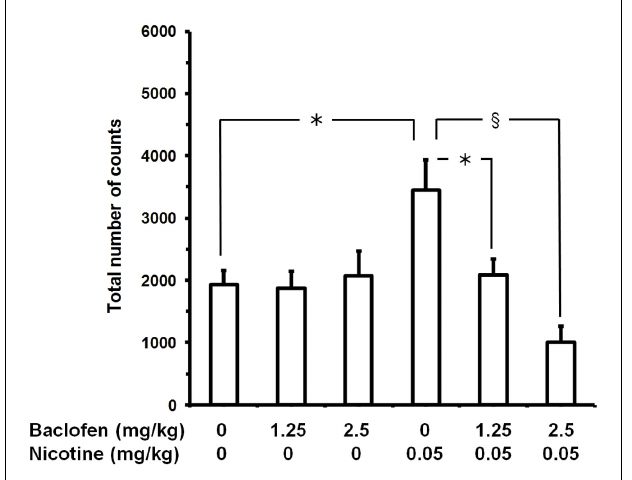
FIGURE 1 | Prevention of nicotine-induced hyperlocomotion by baclofen in male CD1 mice. Mice were initially treated with baclofen (i.p.); 60min later, mice were treated with nicotine (tartrate salt). Locomotor activity recording started immediately after nicotine administration and lasted for 20 consecutive min. Data are expressed as mean ± SEM of the total number of counts (photocell breaks) recorded automatically by the apparatus in n = 14 mice. *, P < 0.01 and §, P < 0.0005 (Newman–Keuls